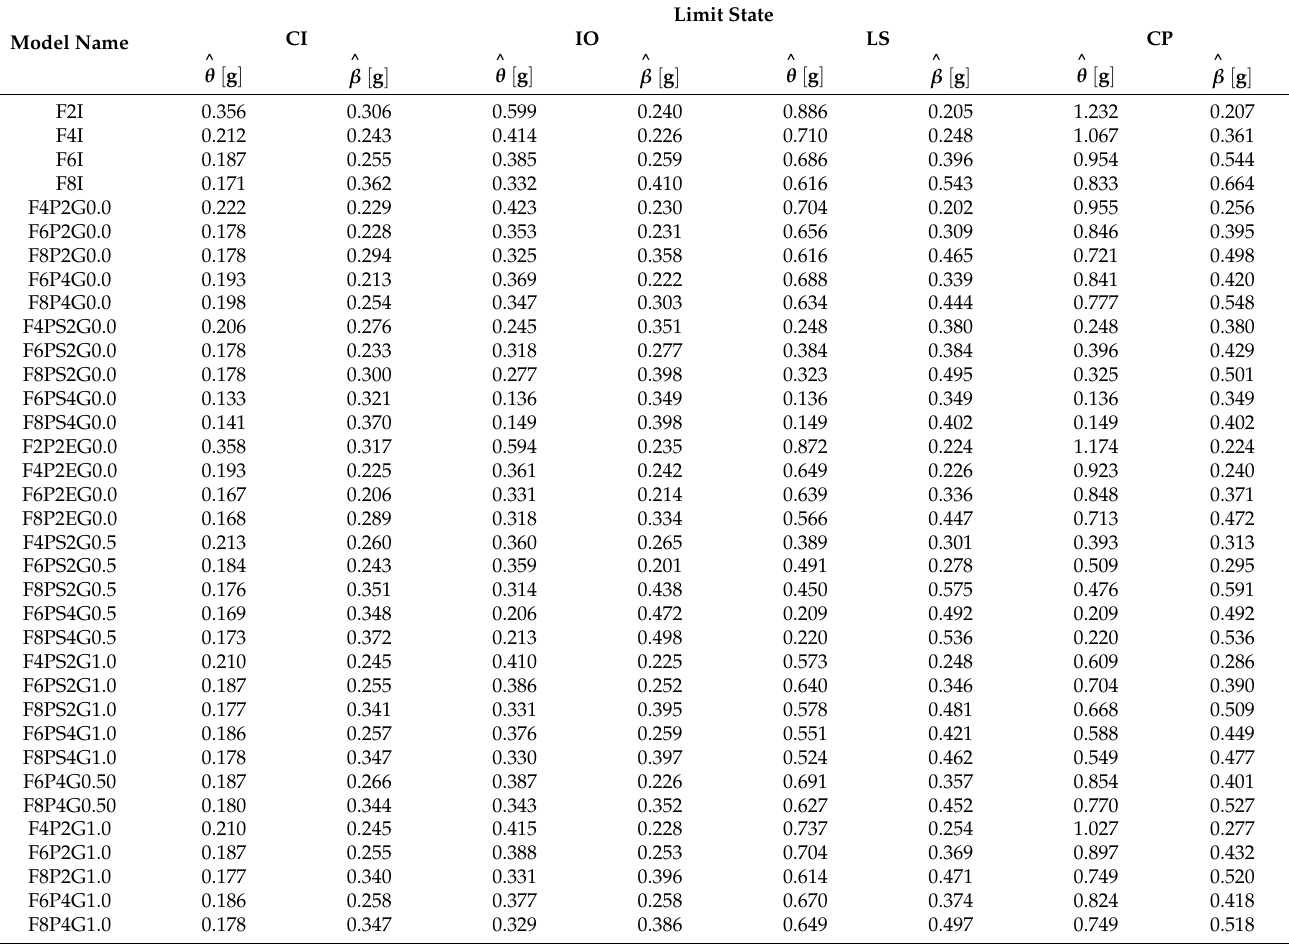
Figure 23. Median of the fragility functions for all the structures and the four limit states: 4-storey ( a ), 6-storey ( b ) and 8-storey ( c ) structures. Table 3. Parameters of the fragility functions obtained for the different structures.